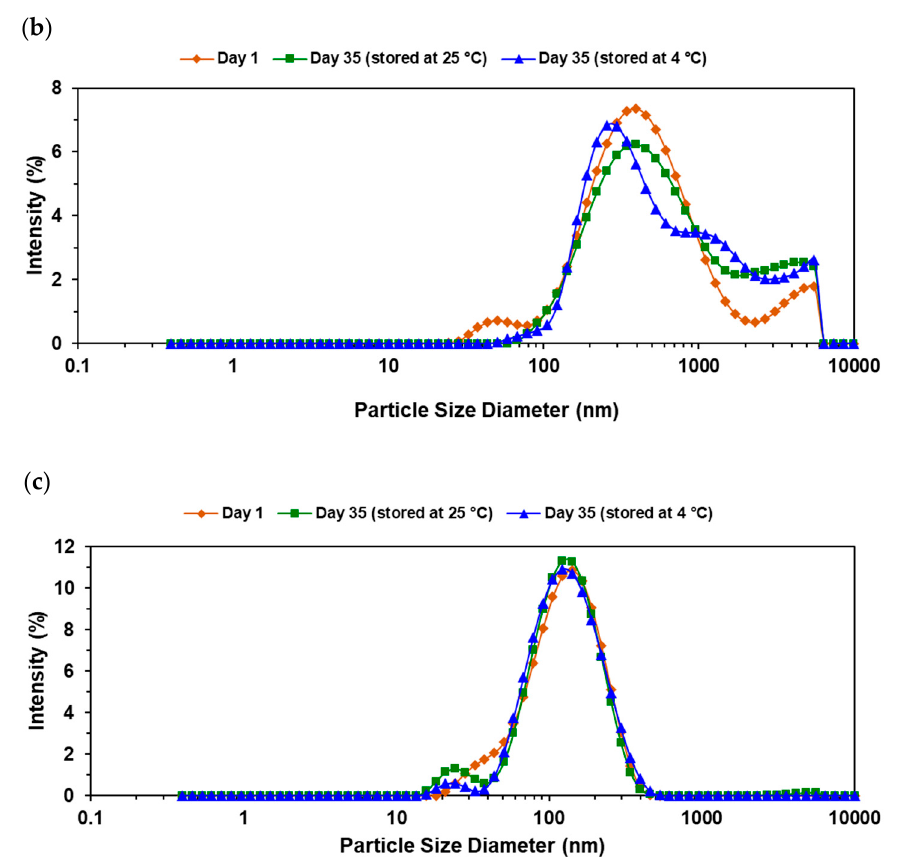
Figure 3. Particle size distribution of W/O/W emulsions (optimal formulations) prepared by three different devices after 1 day, and after 35 days of storage at room temperature and at 4 ° C: ( a ) Rotor-stator mixer; ( b ) Ultrasonic homogenizer; ( c ) Microfluidizer processor.